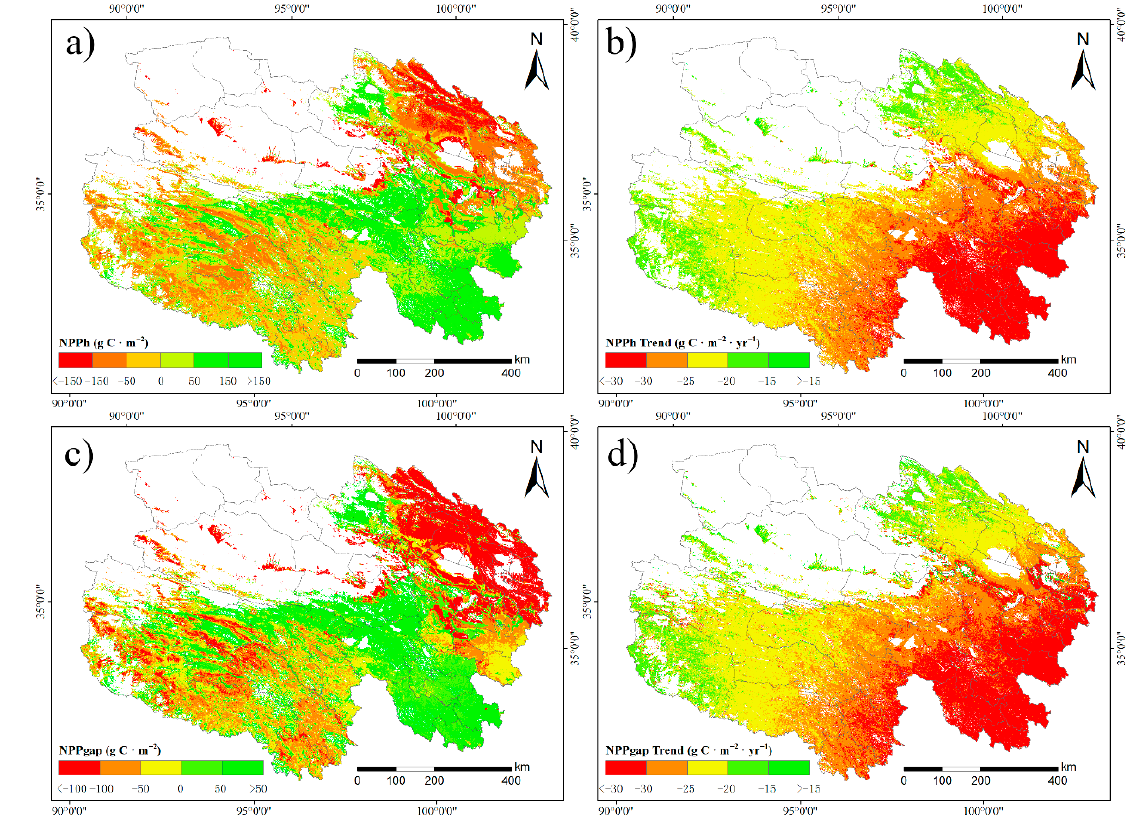
Figure 5. Spatiotemporal patterns of NPP h and NPP gap in alpine grassland in Qinghai Province from 2005 to 2018: ( a ) mean annual NPP h ; ( b ) change trend of NPP h ; ( c ) mean annual NPP gap ; ( d ) change trend of NPP gap